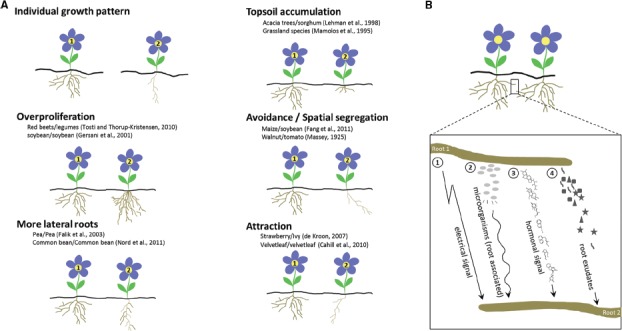
Figure 1. Common root responses to neighboring plants and possible mechanisms of root identity recognition. (A) Range of root responses toward neighboring roots. Two plants are depicted (plant 1 and 2) of which plant 2 shows a differential root response because it is neighbored with plant 1. Plants 1 and 2 can be either of the same species or of different species. Examples (both intra- and interspecifically) of interacting species, are provided for each response: overproliferation of the root system, i.e., root biomass changes which may include main root length increases, more adventitious rooting, more and higher order lateral roots, etc.; increased lateral rooting; accumulation in the top soil; spatial segregation; root attraction. (B) Four proposed mechanisms in self/non-self root recognition: resonant amplification of electrical or hormonal signals (Schenk et al., 1999; Falik et al., 2003); root associated microorganisms and/or their secreted substances (Steenhoudt and Vanderleyden, 2000); and soluble metabolites in root exudates (Biedrzycki et al., 2010; Caffaro et al., 2011; Fang et al., 2013; Semchenko et al., 2014). A non-self root–root interaction is shown.